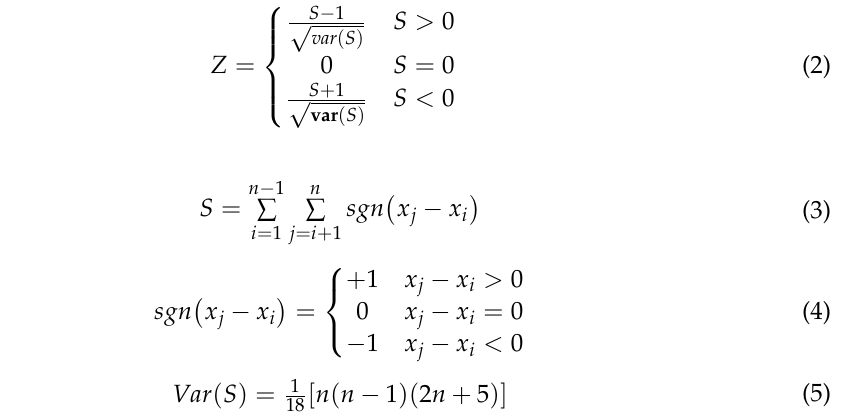
Table 1. Summary of the datasets used in the study.